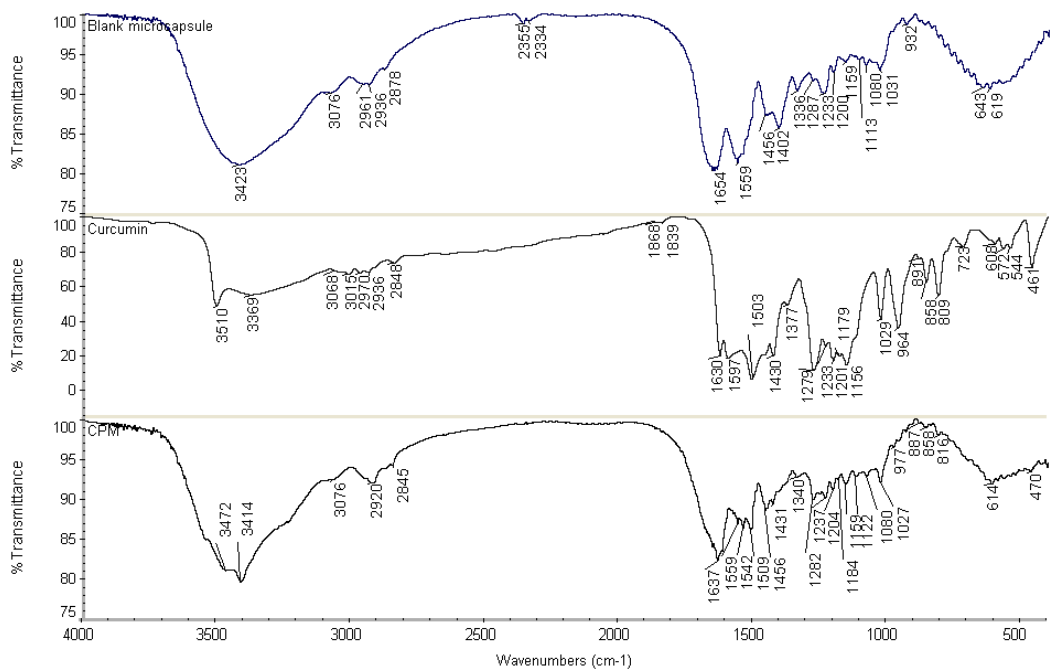
Figure 6. Fourier transform infrared (FTIR) spectra of blank microcapsule, free curcuminoids and cross-linked CPM.